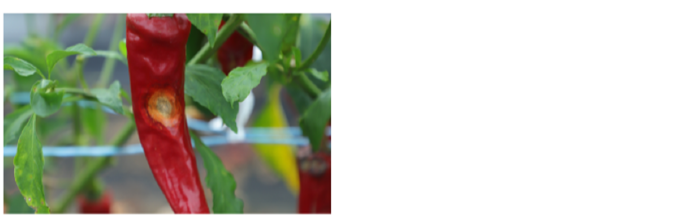
Figure 14. Generated sentence (predicted caption) and correct answer sentence (real caption) for the image of an Anthracnose-infected pepper.